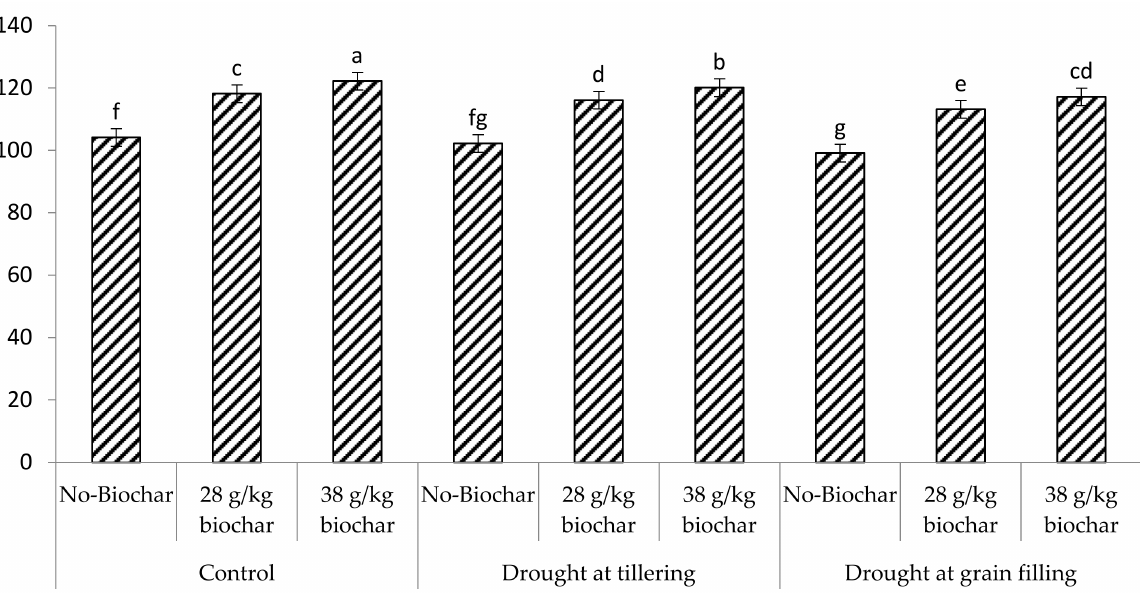
Figure 1. Effect of Biochar on Microbial biomass-C of soil under drought.